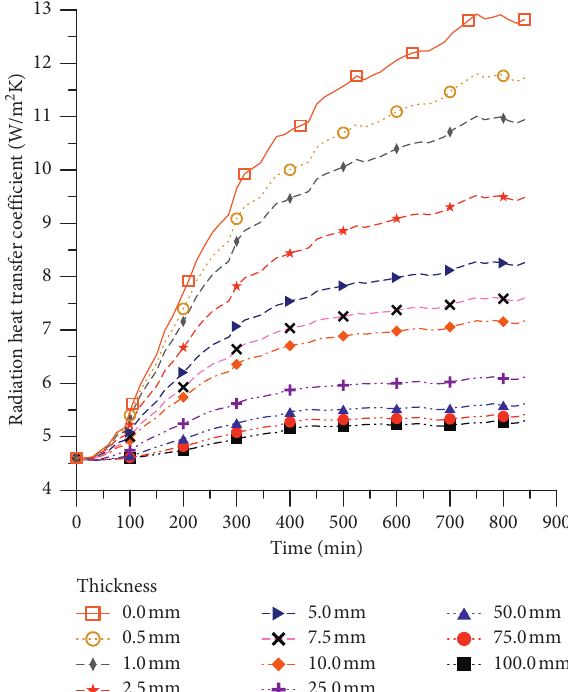
Figure 8: Convective heat transfer coefficient during the heating process for different ceramic fiber thicknesses.